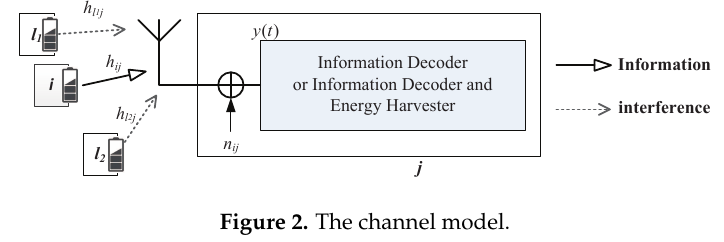
Figure 2. The channel model.